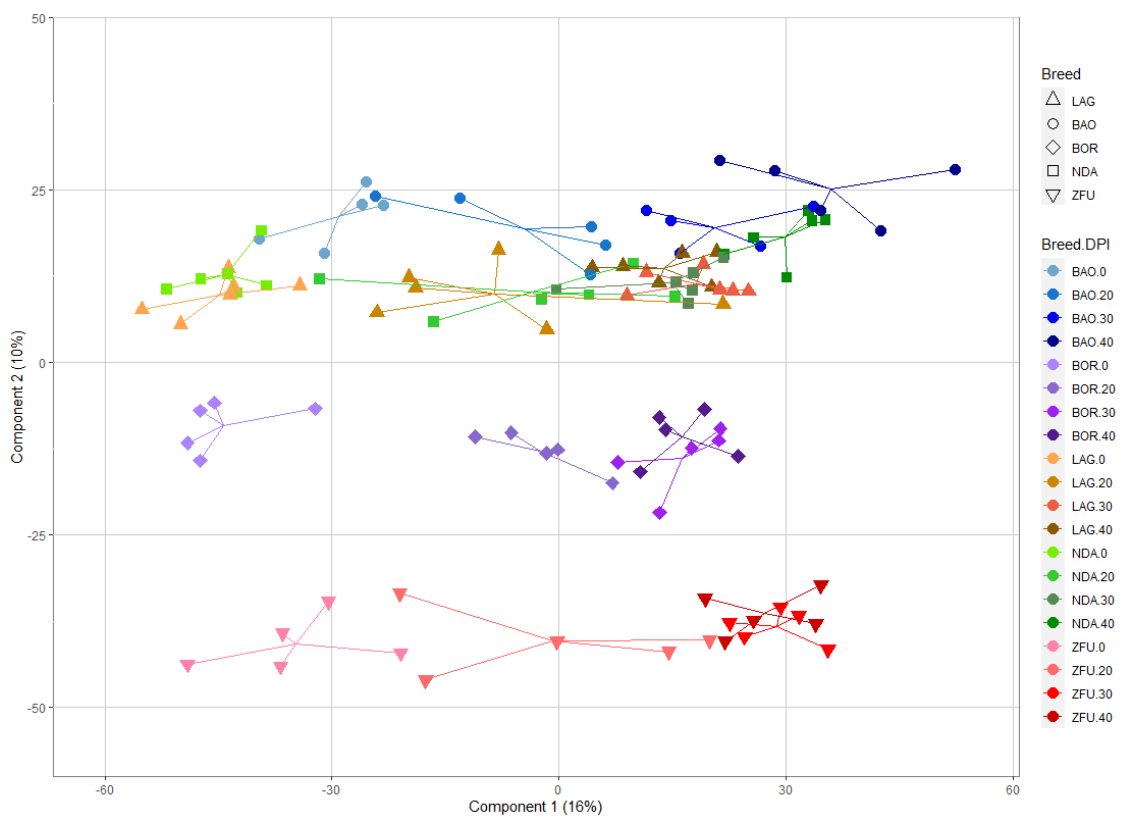
Figure 2 - Principal components analysis of cattle RNA-seq libraries based on normalized genes counts. Each point represents a RNA-seq library that corresponds to an animal sampled at a given DPI and that is plotted on the first two principal components according to its coordinates. Libraries are identified according to the breed and the sampling date. Arrows link a library to the centroid of the corresponding breed and sampling date treatment. Each breed is represented by a different shape and by a color gradient, and each color is graded from light to dark shades corresponding to days post- infection respectively DPI.0, 20, 30 and 40. ZFU animals are in red and triangle down, BOR animals are in violet and diamond, LAG animals are in orange and triangle, BAO animals are in blue and circle, and NDA animals are in green and square. Percentages of variance explanation of the first two components are